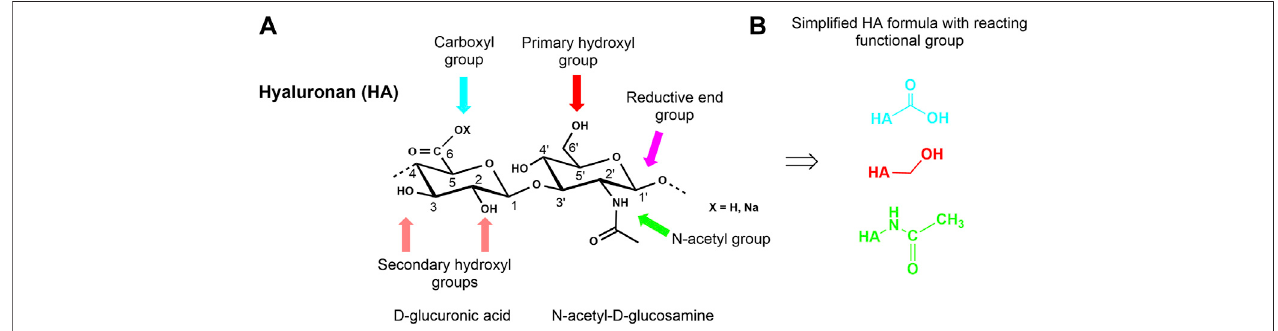
FIGURE 3 | Chemical structure of a HA disaccharide repeating unit showing the reactive functional groups (A) and presentation of simpli fi ed HA formulas with reaction centers involved in the different modi fi cations (B) .